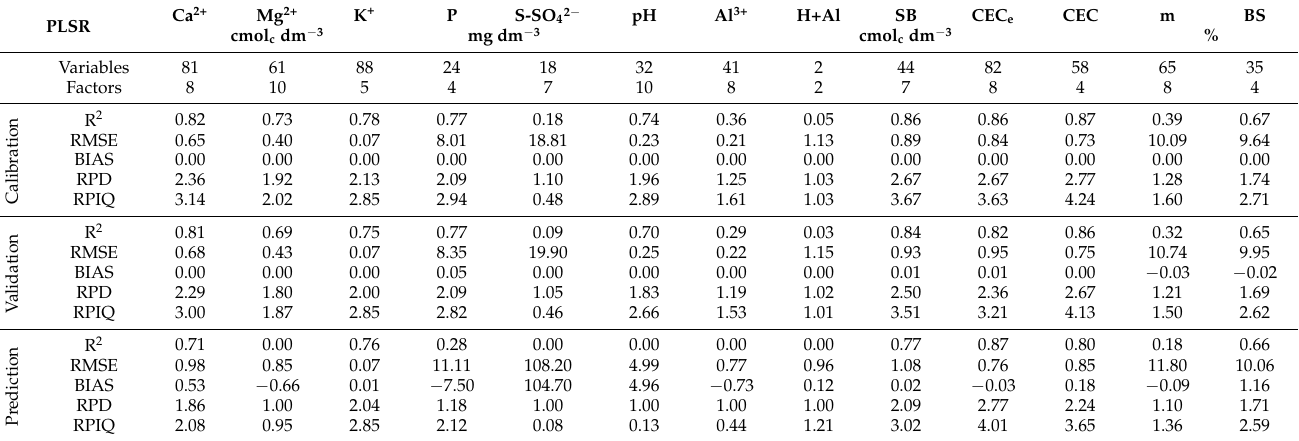
Table 5. Statistical parameters of PLSR models developed from the third soil assessment (with iPLS selection).